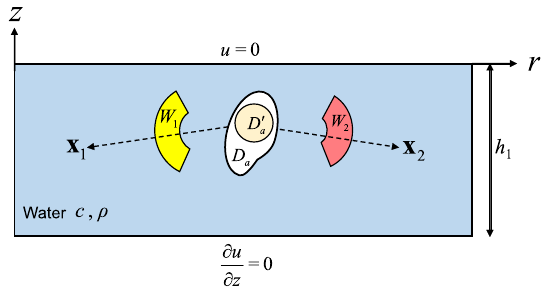
Figure 2. Sketch of the problem geometry showing the near controls D 1 , D 2 and the far fi eld directions x 1 and x 2 in homogeneous ocean with constant